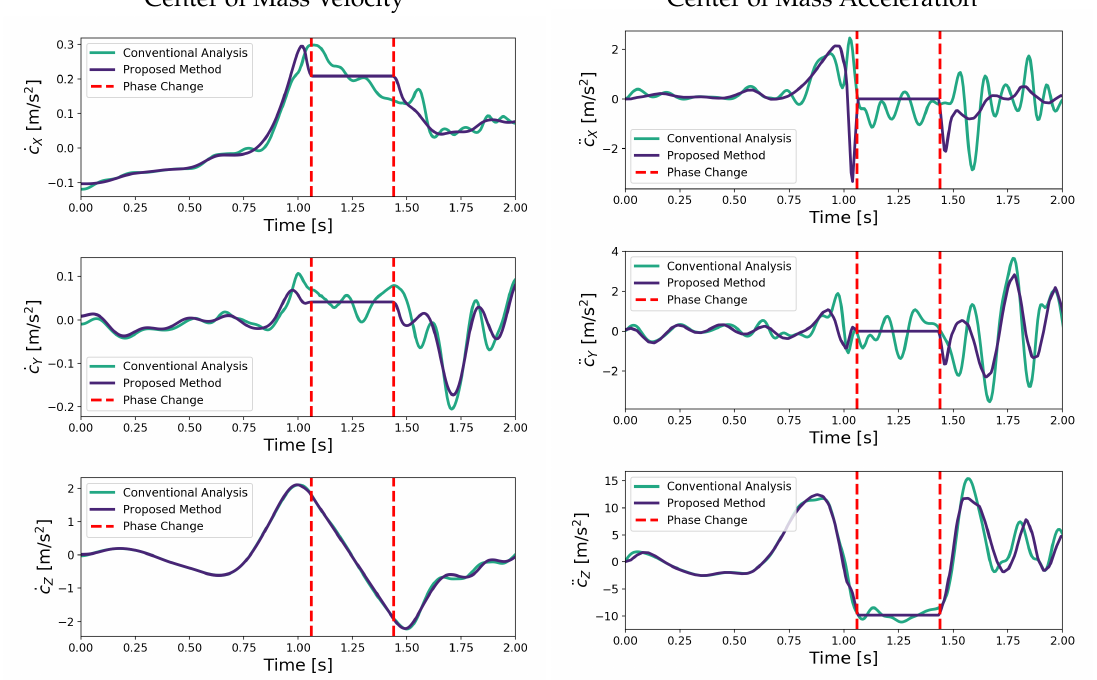
Figure 7. Center of Mass velocity and acceleration in global coordinates during the motion. Results from the conventional method are plotted in green, the proposed method is plotted in purple. During the flight phase all horizontal accelerations are supposed to be zero and the according velocities should be constant. We see inconsistencies and changes in the range of 20% for the conventional method whereas the proposed method is physically